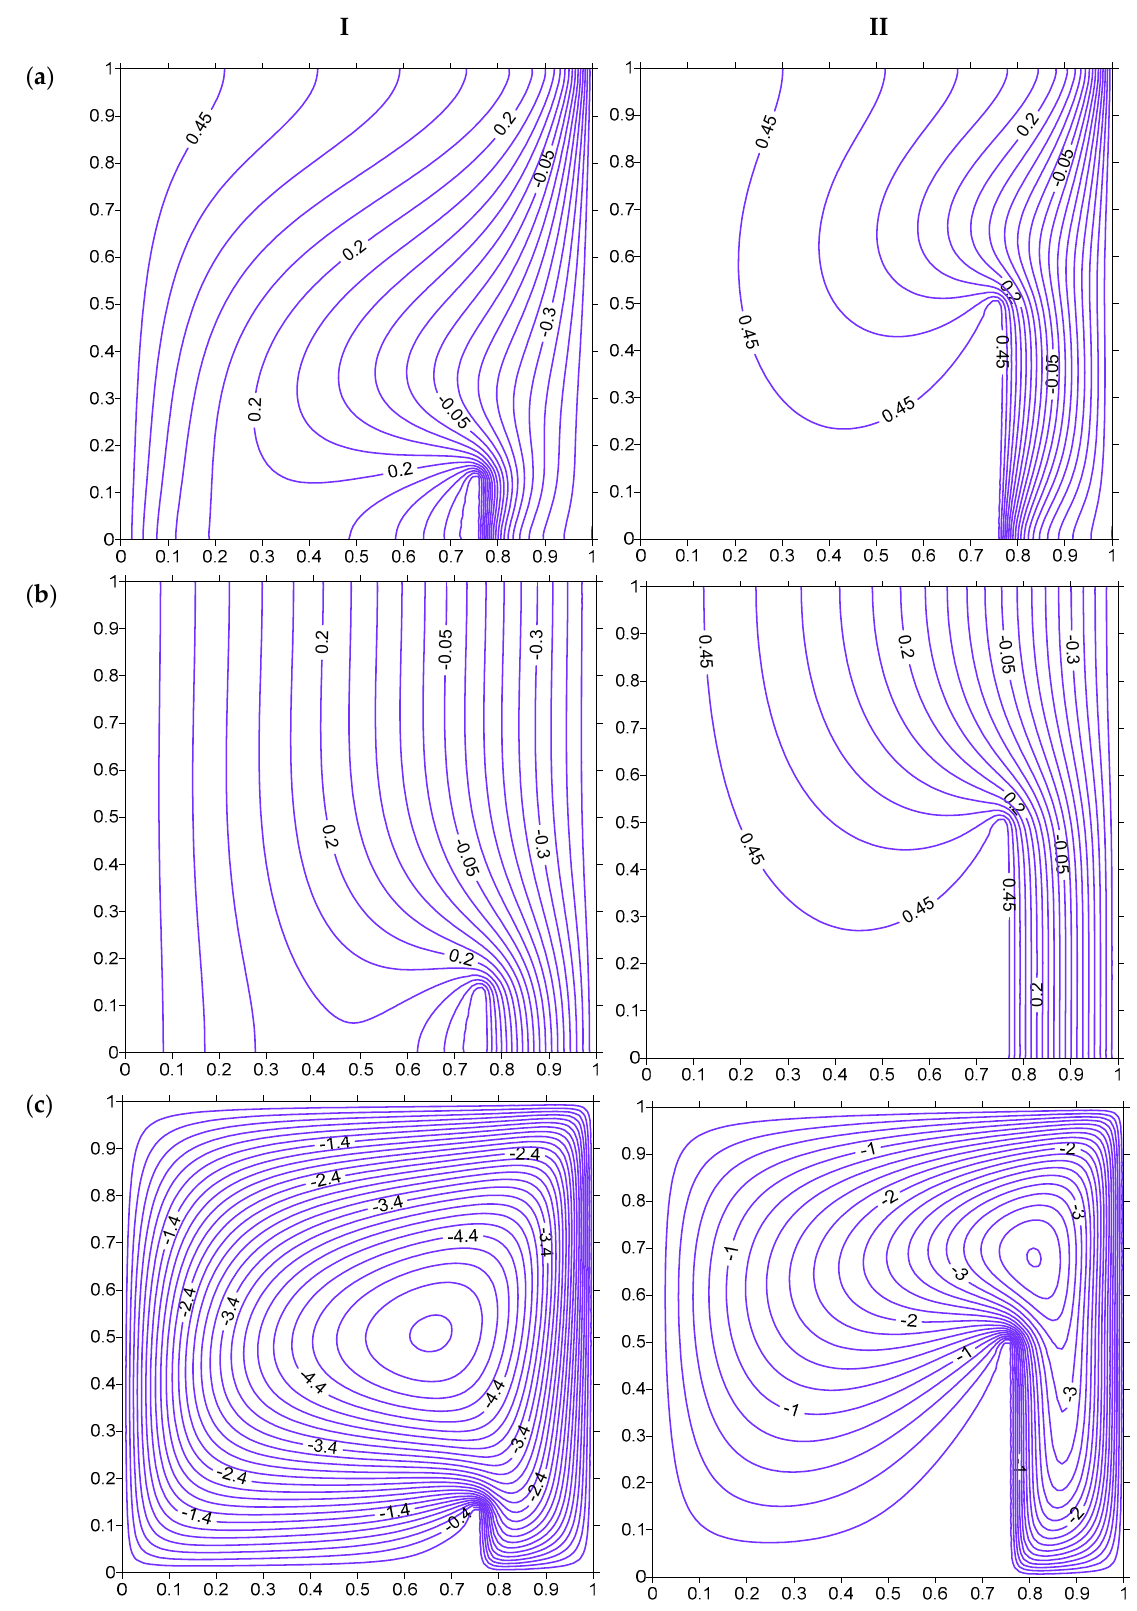
Figure 21. Isotherms (( a ) Fluid, ( b ) Solid), and streamlines ( c ), at Ra = 100 , H = 5 , Kr = 1 , Rd = 0 for strip at x = 0.75. ( I ) HH = 12.5%. ( II ) HH =